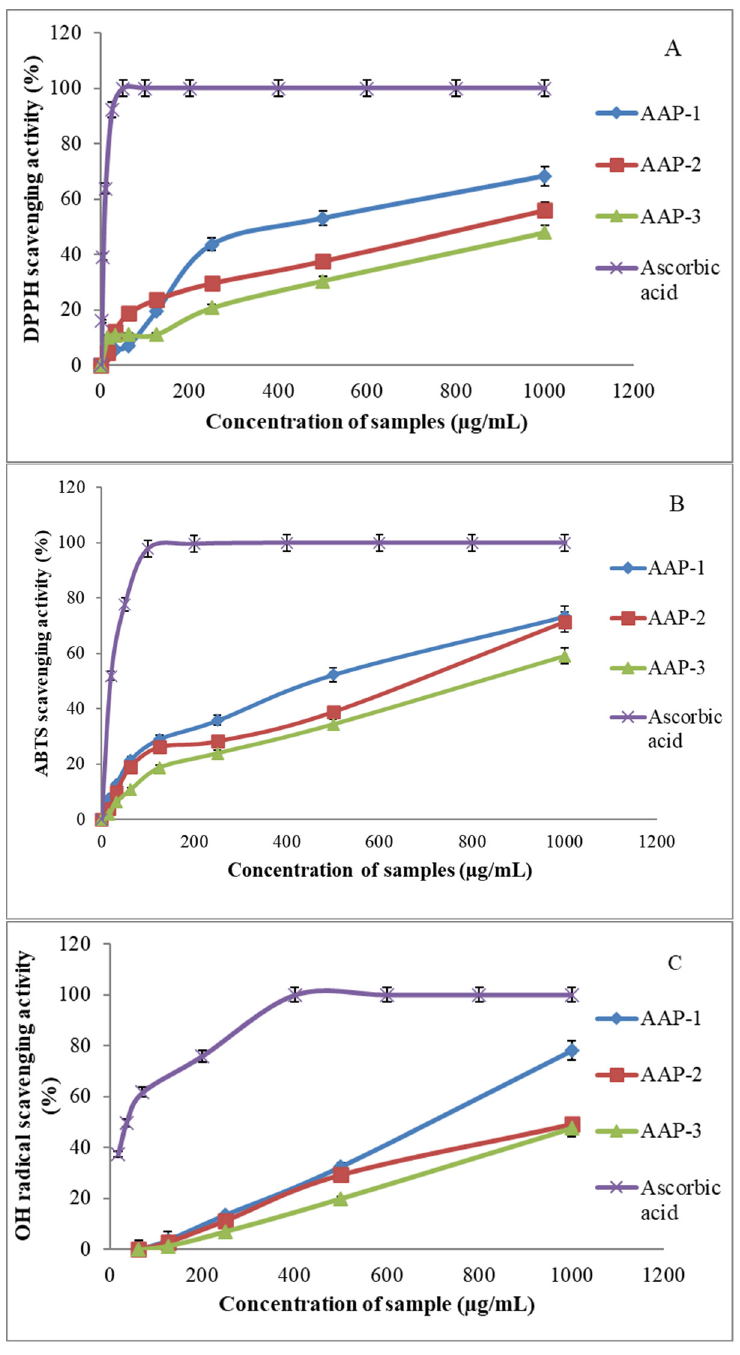
Figure 5. Antioxidant activities of polysaccharide fractions of A . annua . ( A ) DPPH free radical scavenging activity of the AAPs. ( B ) ABTS free radical scavenging activity of the AAPs. ( C ) Hydroxyl radical scavenging activity of the AAPs. Results are the mean ± SD of three separate experiments, and all the results were compared with the standard (ascorbic acid).